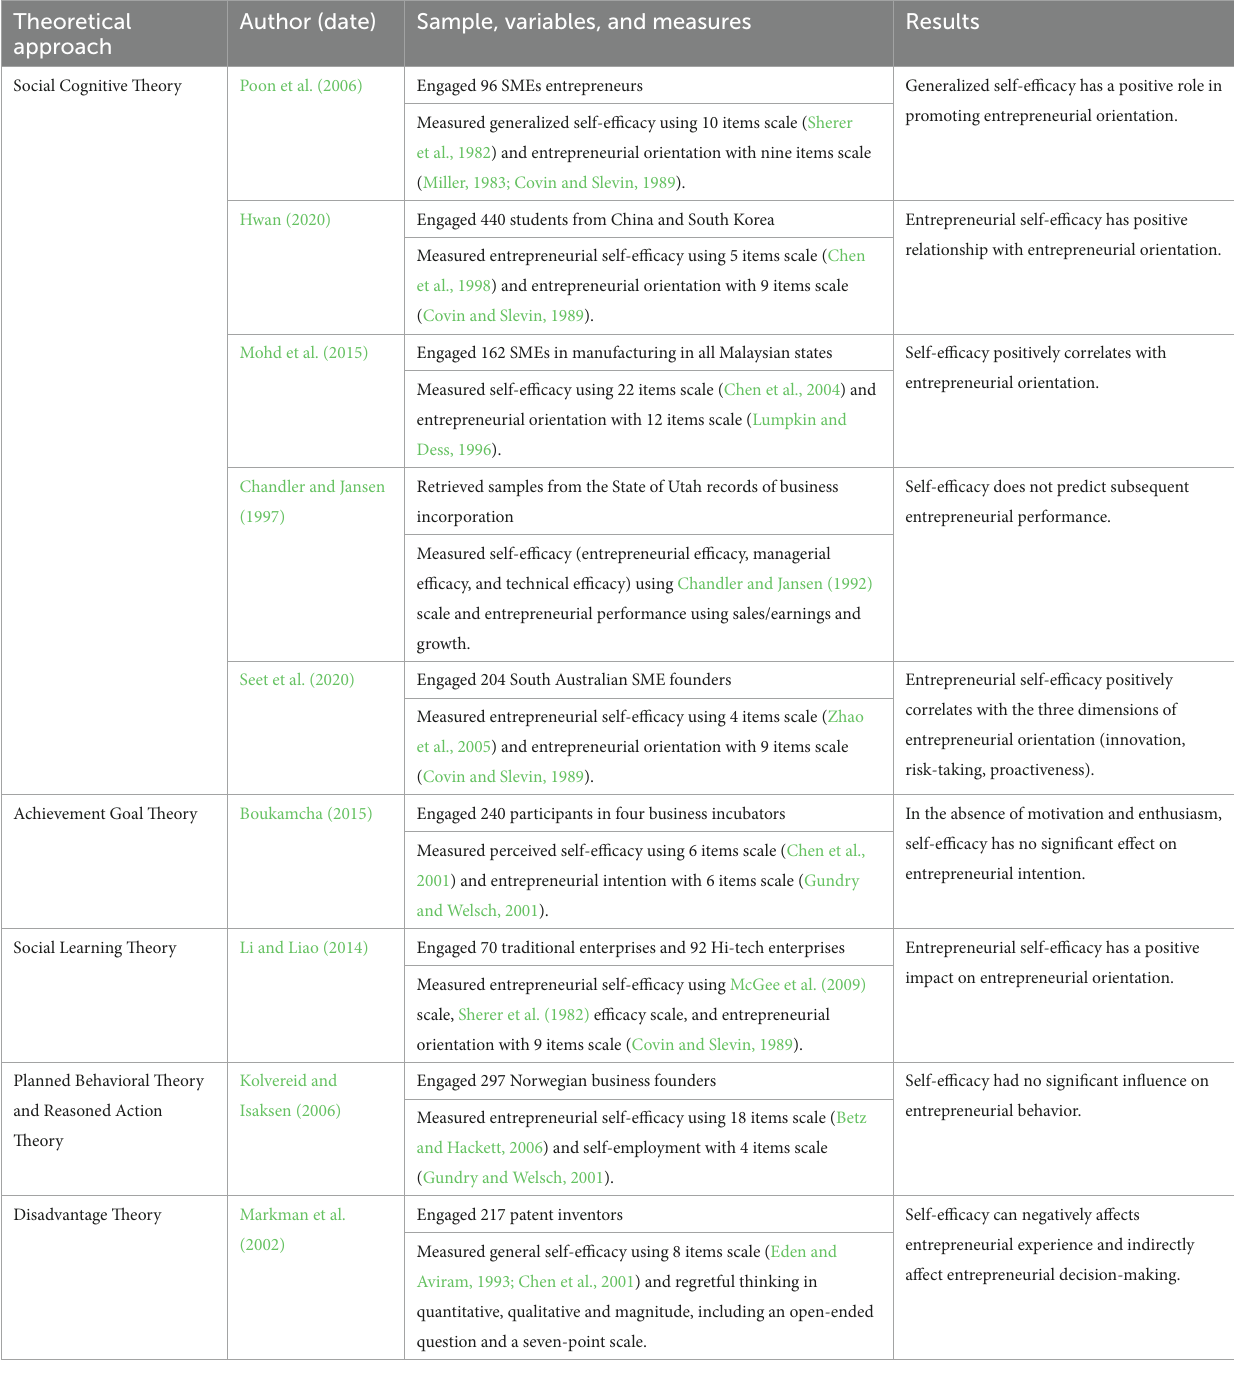
TABLE 1 Summary of studies linking entrepreneurial self-efficacy and entrepreneurial